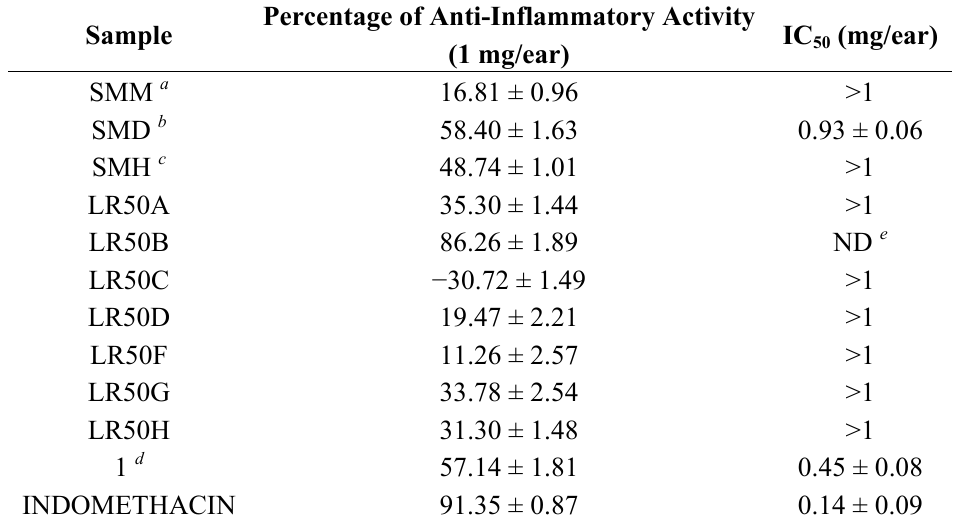
Table 1. Anti-inflammatory activity of the extracts, fractions LR50 A-H and compound 1